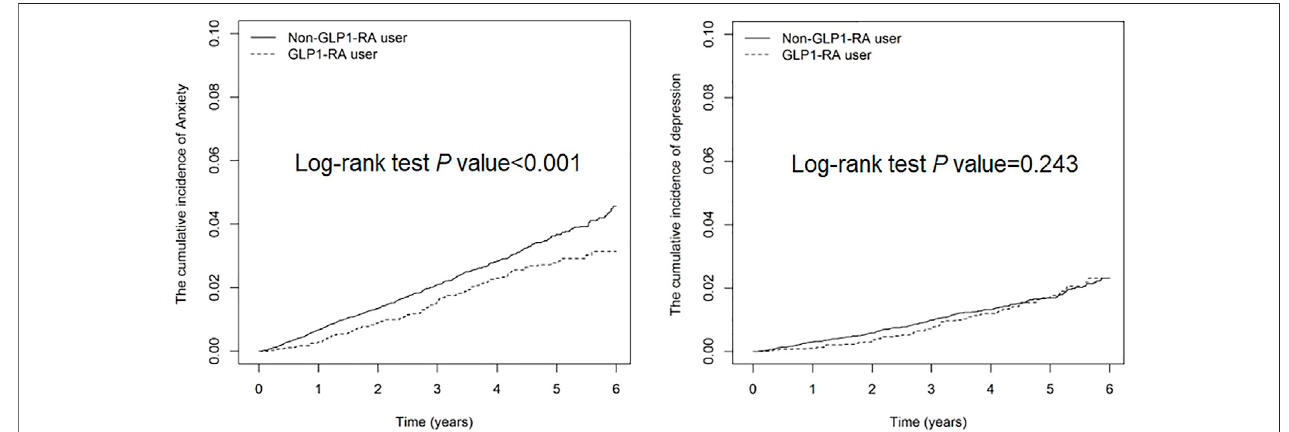
FIGURE 2 | Cumulative incidence of depression and anxiety in diabetes patients with/without GLP1-RA.